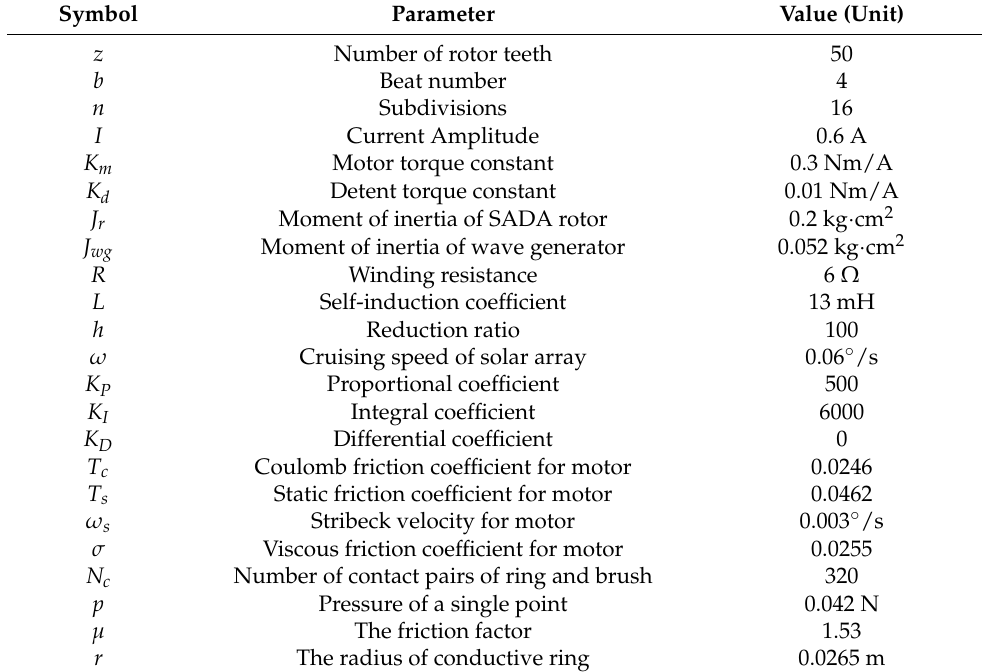
Table 3. Parameters of the SADA.